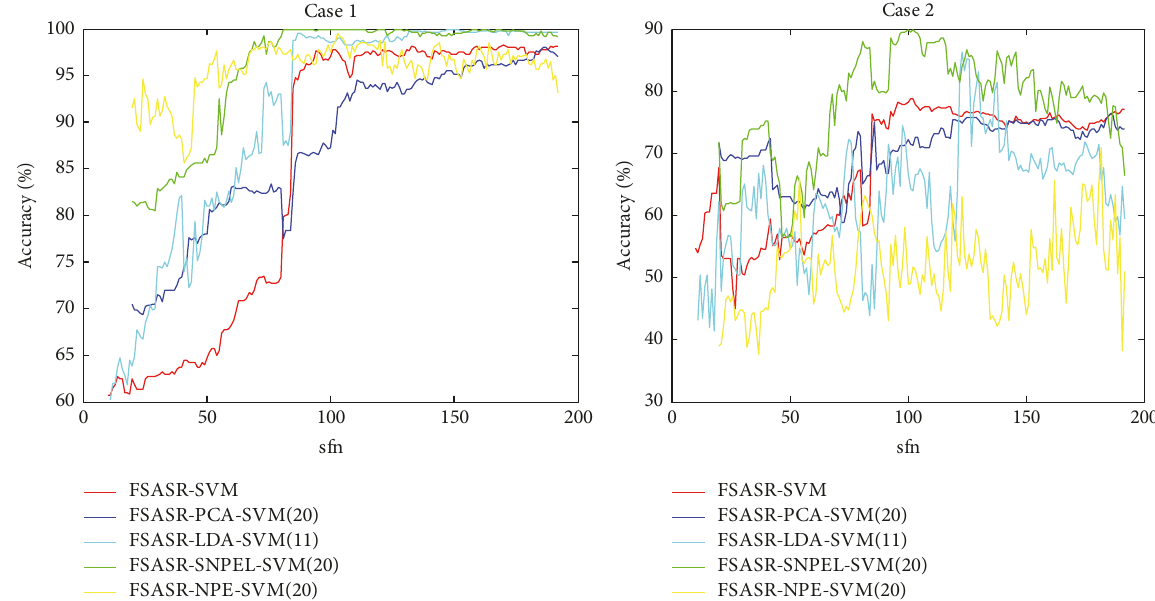
Figure 34: The diagnosis results of the testing set of two cases with the use of FSASD and different dimensionality reduction methods. The output dimension sizes of PCA, LDA, SNPEL, and NPE are 20, 11, 20, and 20, respectively.